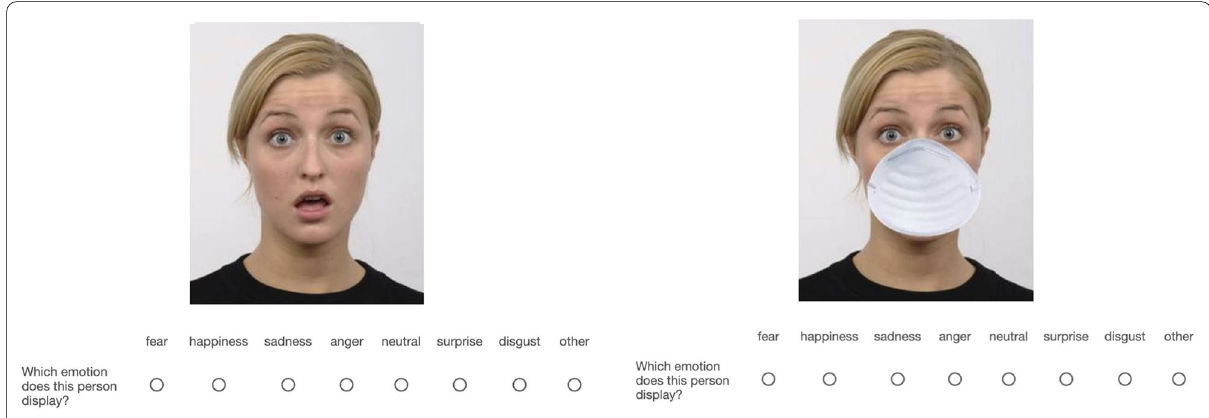
Fig. 1 Sample trials without versus with mask (here: